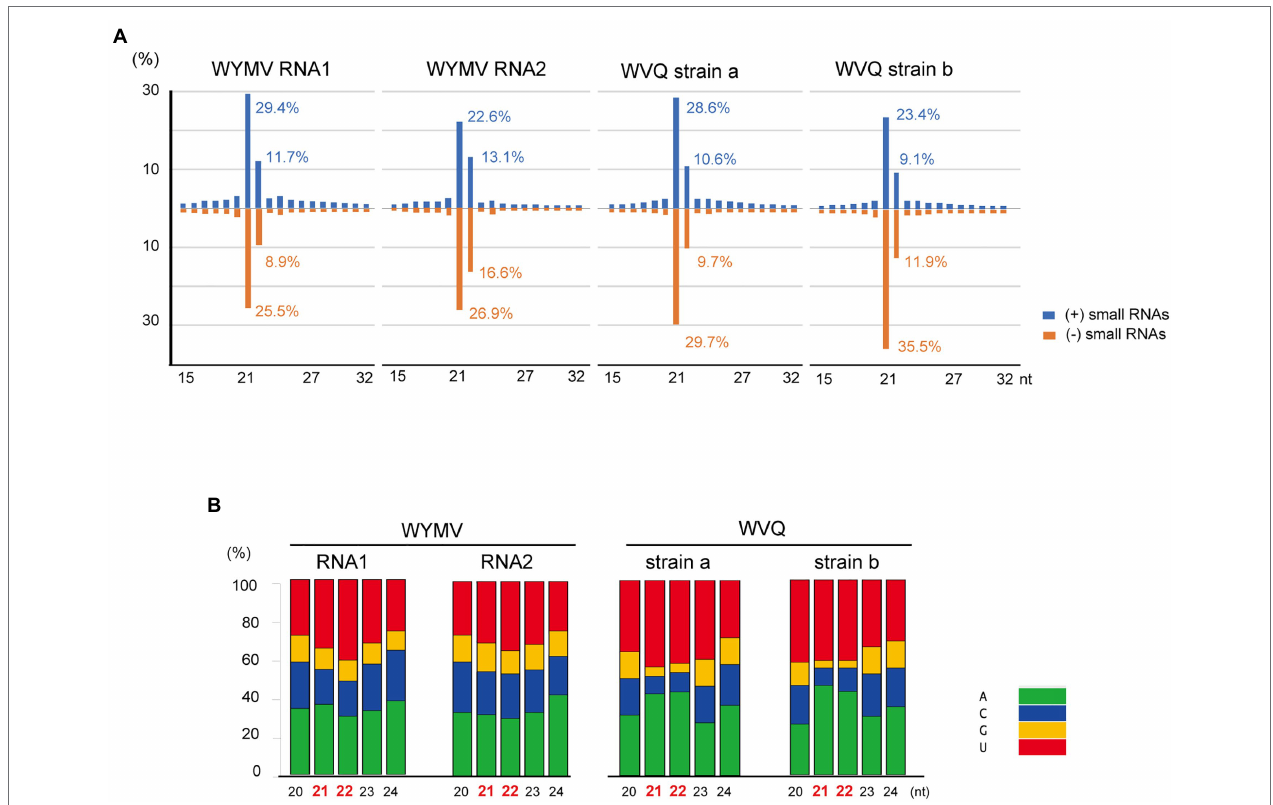
FIGURE 5 | Viral-derived small RNA profiles of WYMV and WVQ in the wheat leaves (the pooled KTH-18-1 and − 2 samples). (A) Proportion of plus (+)- and minus ( − )-strand small RNAs sizes, 15–32 nt, are shown. (B) Proportions of 5 ꞌ -terminal nucleotide sequences of viral-derived small RNAs in the wheat leaves. The composite bar graphs represent the percentage of the 5 ꞌ -terminal nucleotide sequences for each size-class (20–24 nt). Other profiles of the viral-derived small RNAs are presented in Supplementary Figure S6